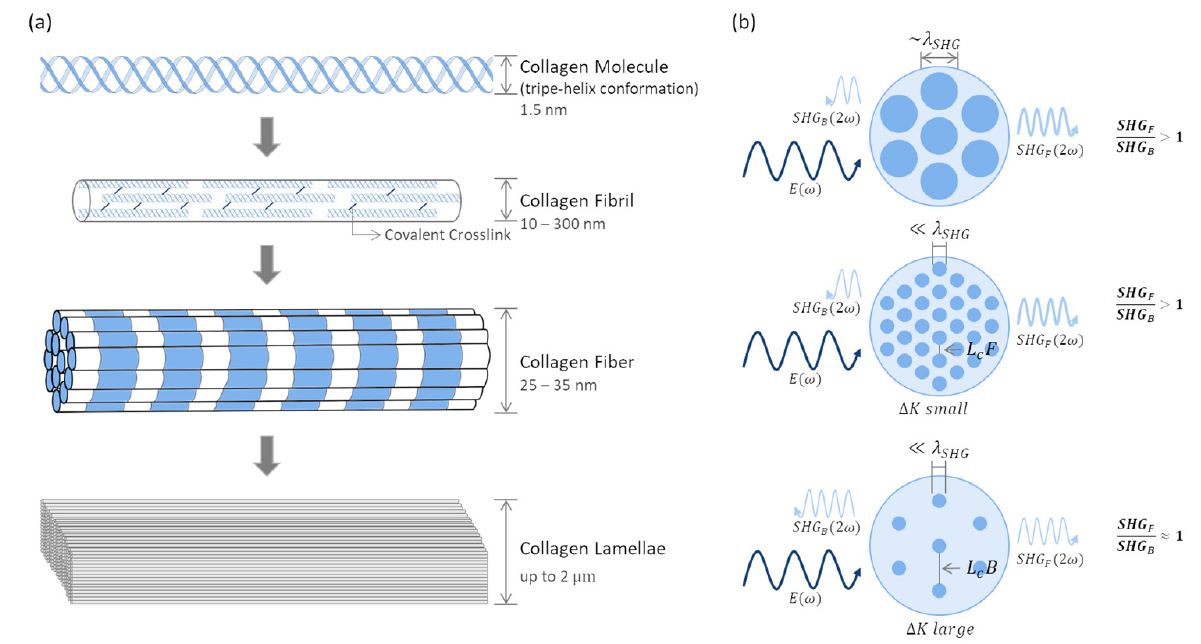
Figure 4. Corneal collagen hierarchic organization ( a ), and influence of fibril diameter and packing arrangement on the directionality and intensity of second-harmonic generation (SHG) signals ( b ). Arrows indicate the direction of signal propagation. E —energy; SHG F and SHG B —forward- and backward-generated SHG; L c F and L c B —coherence length of SHG F and SHG B ; λ SHG —SHG wavelength; ∆ k —phase